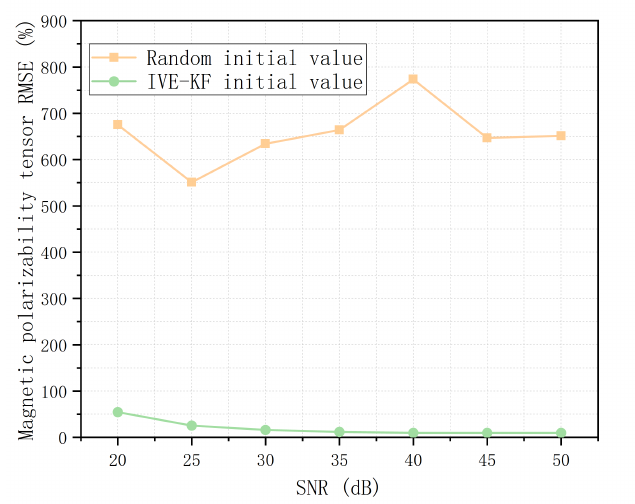
Figure 16. RMSE comparison of the magnetic polarizability tensor errors between the IVE-KF algorithm and filter algorithm given random initial values.